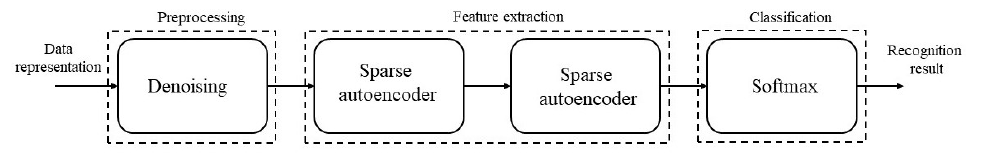
Figure 2. Deep learning based architecture for target